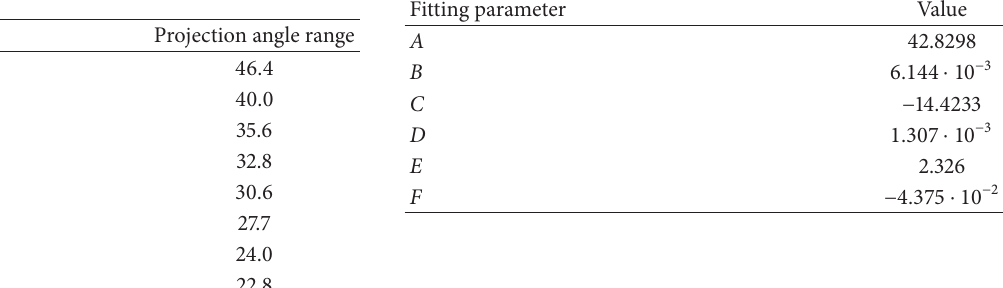
Table 5: The relationship between the curvature and fragment projection angle range.